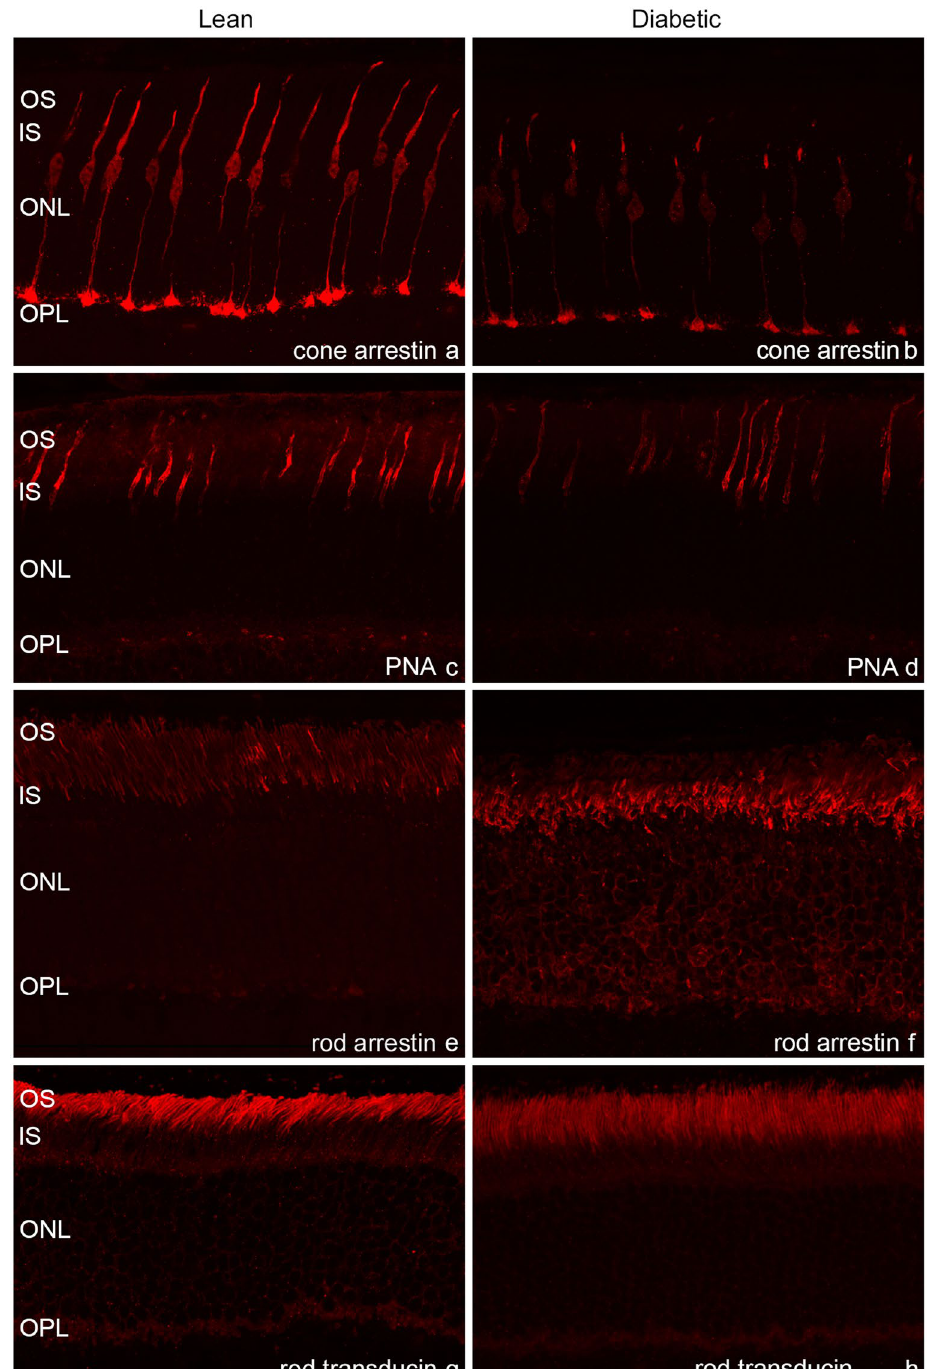
Figure 5. Elements of the phototransduction cascade and cone interphotoreceptor matrix in diabetes. Severe outer segment degeneration of cones was also evident with cone arrestin antibody (( a) : control, ( b) : diabetic specimens), while PNA staining of the interphotoreceptor matrix of the cones did not show any major difference (( c ): control, ( d ): diabetic). When comparing the expression of the regulatory elements of the rod phototransduction cascade, only minor differences were detected. Whereas in most retinal regions the expression pattern was similar to control ( e ), with rod arrestin a protein mislocalization to the perikarya was detectable ( f ) but only in some regions showing the most deteriorated outer segment morphology. No such change was evident for rod transducin (( g ): control, ( h ): diabetic). OS: outer segment, IS: inner segment, ONL: outer nuclear layer, OPL: outer plexiform layer, Bar : 20 μ